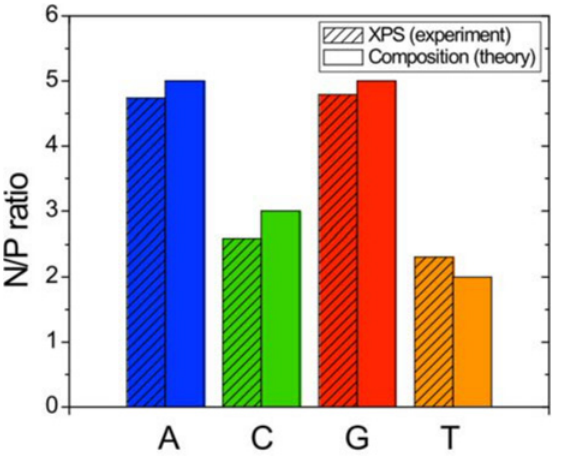
Fig 3. Nitrogen-to-phosphor ratio from XPS analysis of A, C, G and T